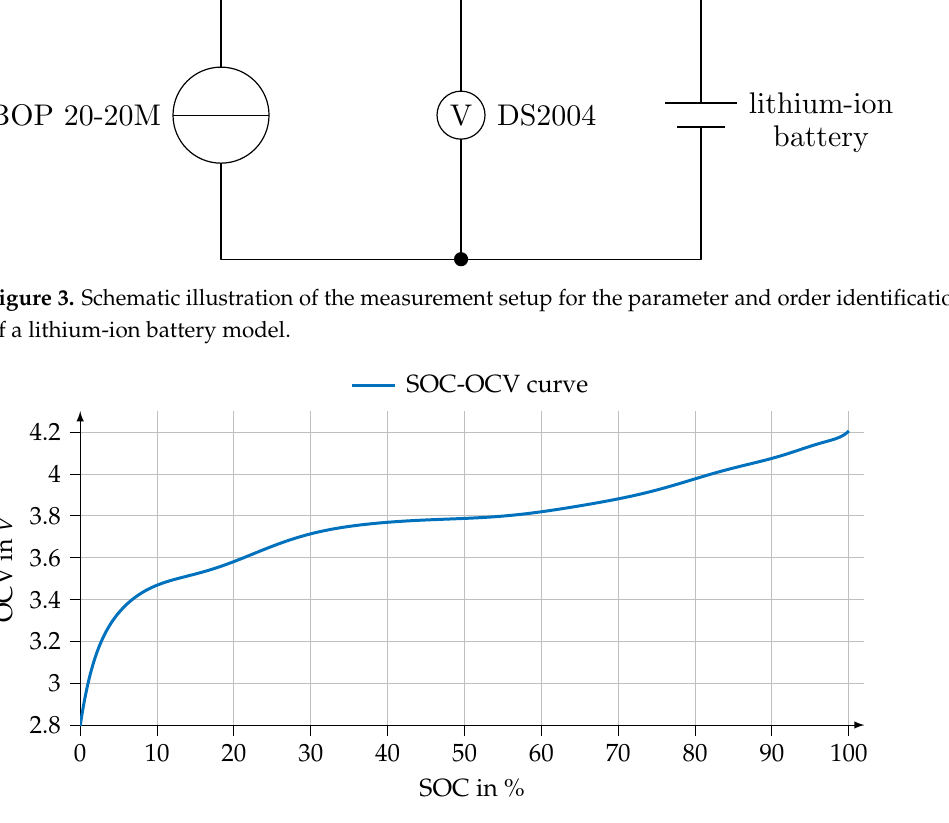
Figure 4. Relation between the state of charge (SOC) and open circuit voltage (OCV) for the used lithium-ion battery of type SLPB 834374H